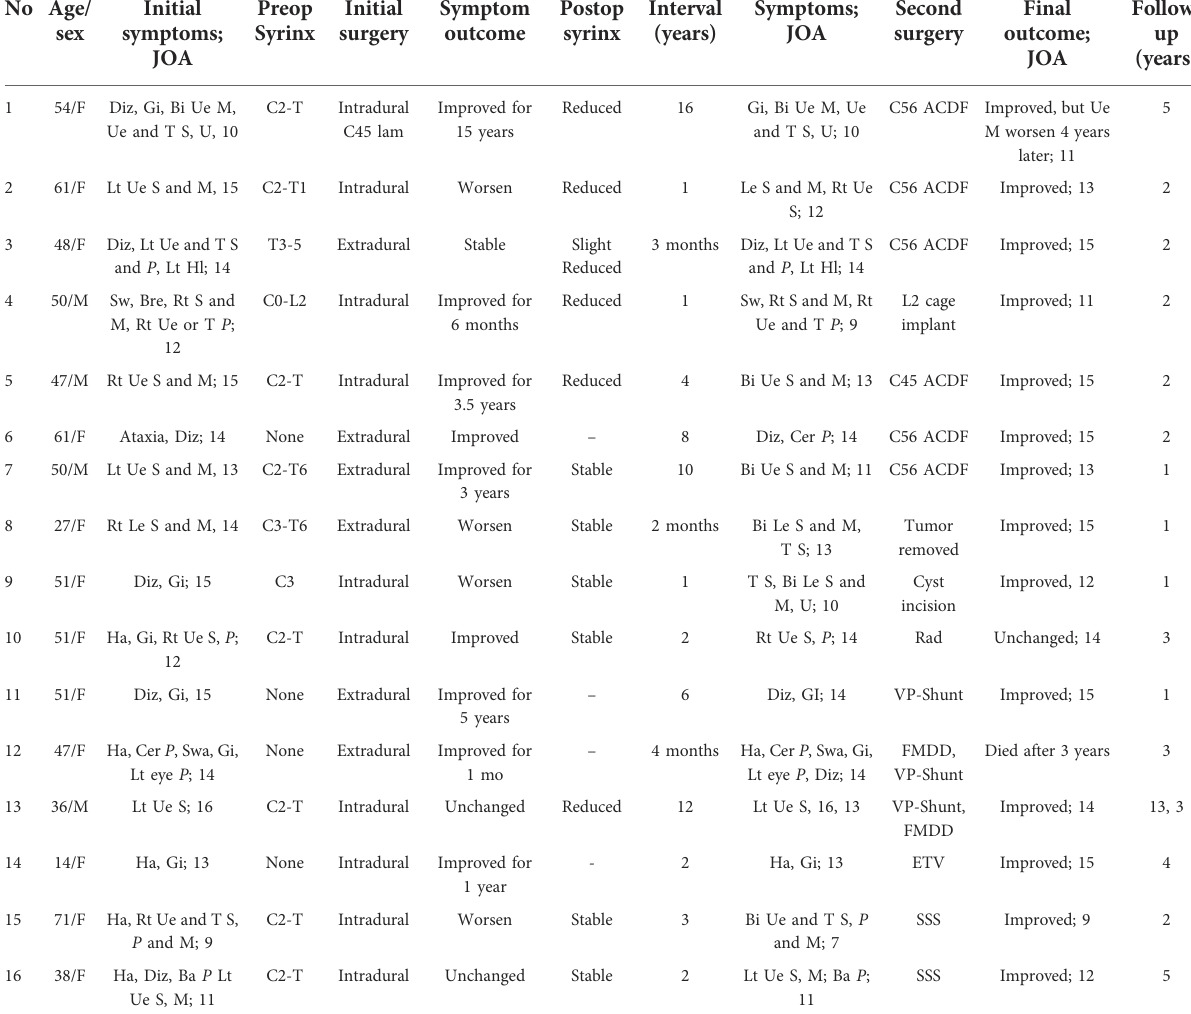
TABLE 3 Clinical or radiological data and management strategies of other patients except Group I and II ( n